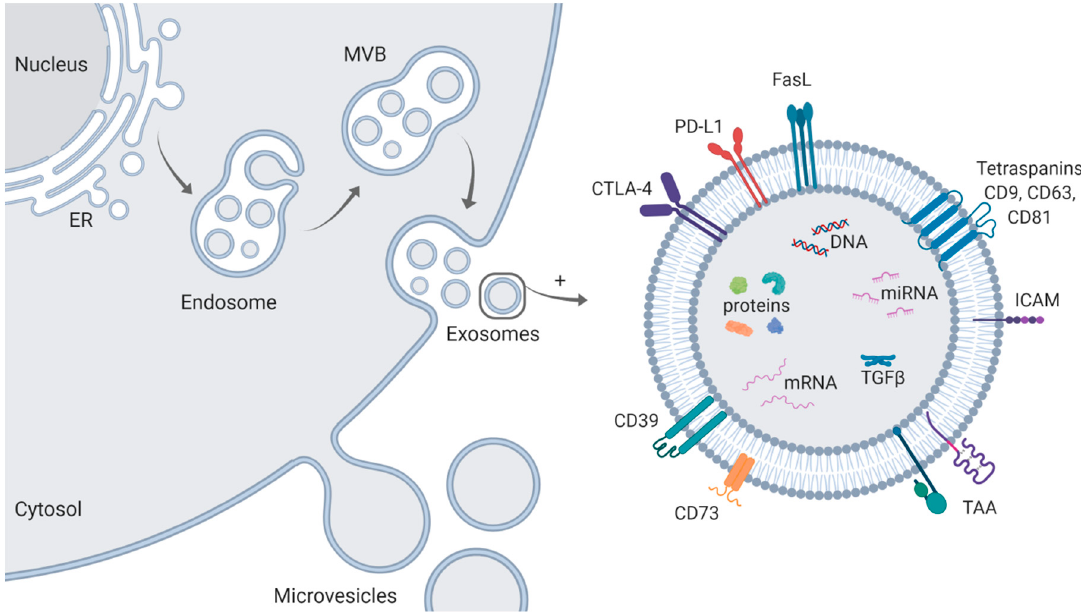
Figure 1. Schematic representation of exosome biogenesis and molecular cargo. Exosomes are formed through inward budding of the endosomal membrane resulting in the formation of multivesicular bodies (MVB). Upon fusion of MVBs with the plasma membrane, exosomes are released in the extracellular space. In contrast, microvesicles are formed by simple budding of the plasma membrane. The molecular cargo of exosomes consists of proteins, miRNA, mRNA, DNA, and lipids. On their surface, they carry the tetraspanins CD9, CD63, and CD81, commonly referred to as “exosomal markers,” adhesion molecules (e.g., intercellular adhesion molecule ICAM) and—in case of TEX—tumor-associated antigens (TAA), which are specific to the cell of origin. Further, the presence of immune suppressive proteins such as CTLA-4, PD-L1, Fas-L, CD39, CD73, and TGF β in HNSCC-derived exosomes has been reported. Figure is created with BioRender.